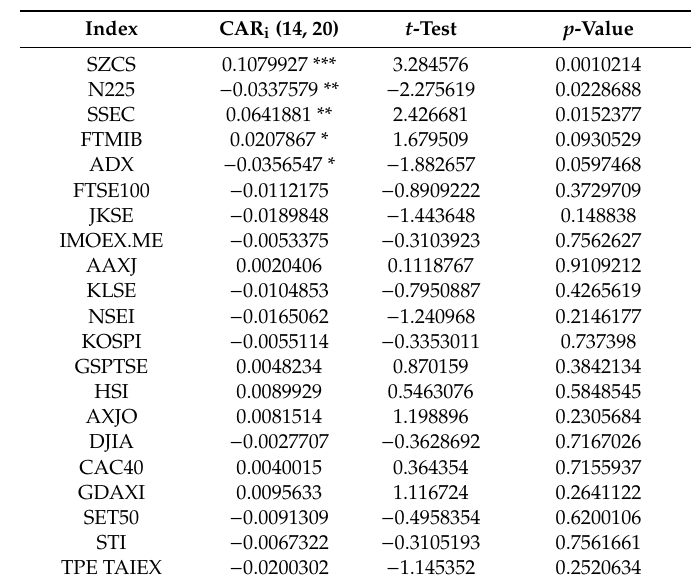
Table 7. Cumulative abnormal return in the event window (14,